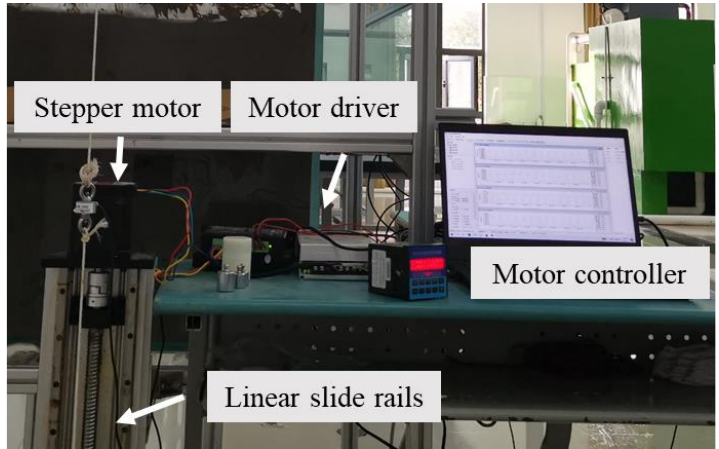
Figure 3. Component of the linear motion module sliding stepper.